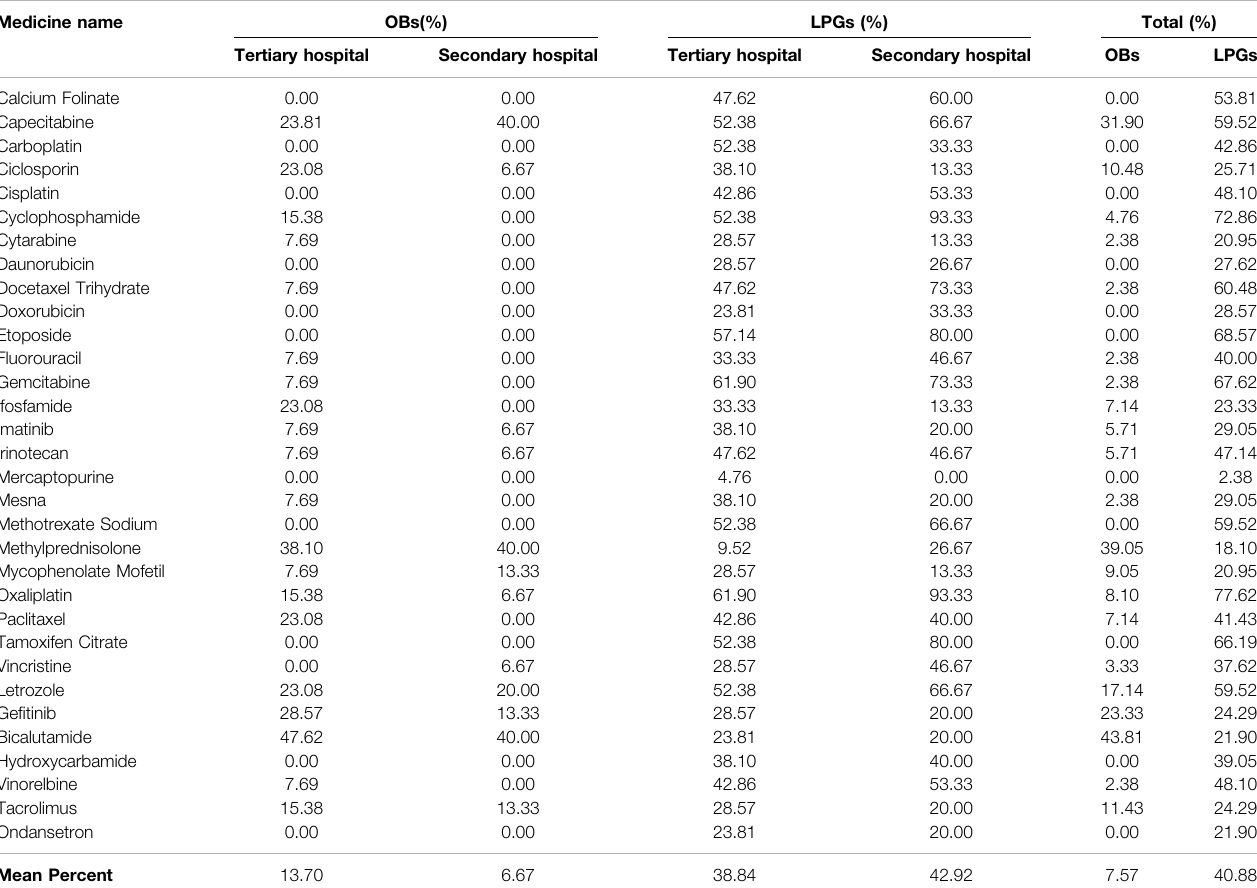
TABLE 2 | Availability of anticancer medicines in Tertiary and Secondary